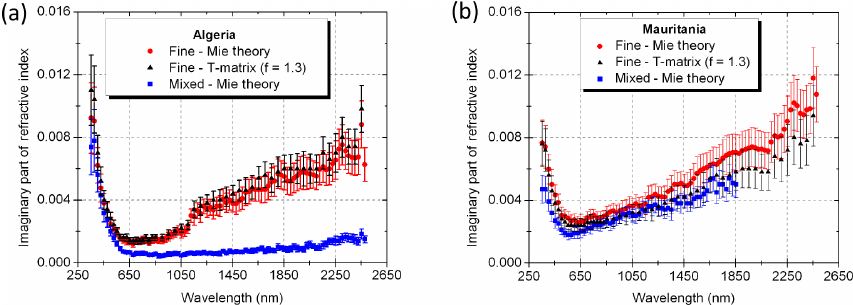
Figure 10. Imaginary part of the complex refractive index derived for mixed and fine particles of Saharan dust from (a) Algeria and (b) Mauritania (group 1). Mie theory and T-matrix were used assuming the real part of the refractive index Re(m) = 1.56 and grain den- sity d p =2.69gcm − 3 . The error bars of the imaginary part of the complex refractive index were estimated by studying the sensitivity of the minimization method to the uncertainties of the real part of the refractive index, the mass absorption efficiency, the particles’ cross sections, volume, and grain density.